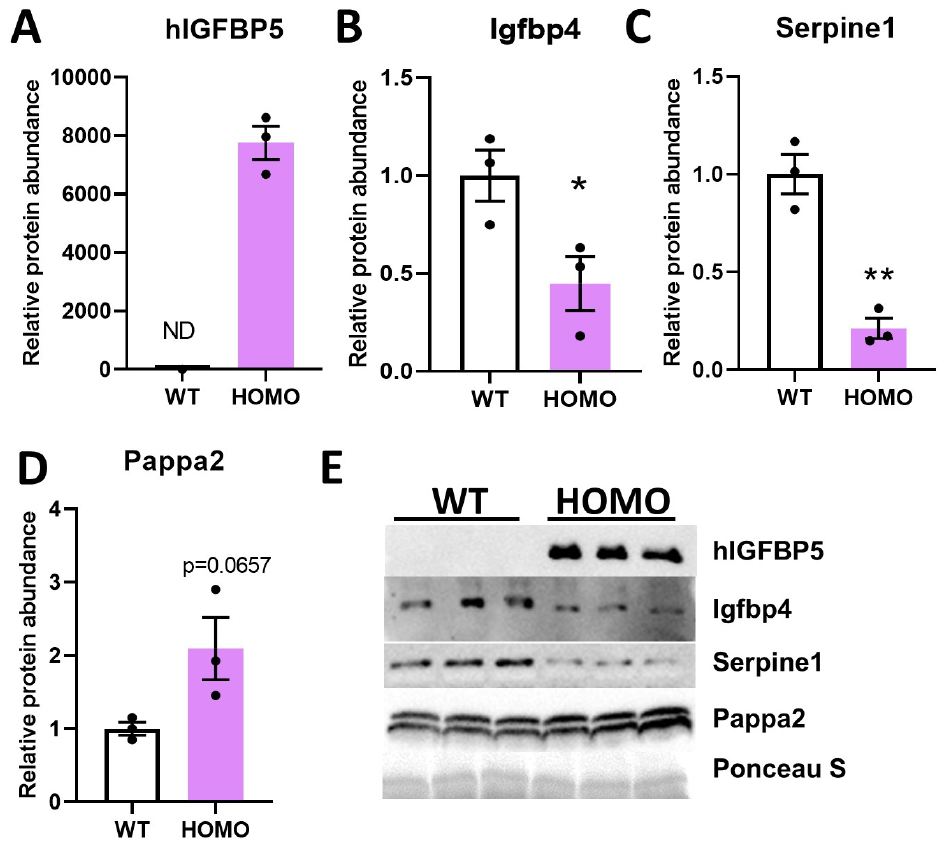
Figure 5. Effect of hIGFBP5 on the secretion of Igfbp4, Serpine1 and Pappa2. Conditioned media of cultured pFBs of hIGFBP5 HOMO and WT mice were analyzed by immunoblotting for selected proteins. Quantification of immunoblots (n = 3) for the protein abundance of ( A ) hIGFBP5, ( B ) Igfbp4, ( C ) Serpine1 and ( D ) Pappa2. * p < 0.05. ** p < 0.01. ND: non-detectable. WT: wild type female mice, HOMO: hIGFBP5 homozygous female mice. ( E ) Representative immunoblots showing protein abundance of hIGFBP5, Igfbp4, Serpine1 and Pappa2 in conditioned media of cultured pFBs of hIGFBP5 HOMO and WT mice. Ponceau S staining was used as loading